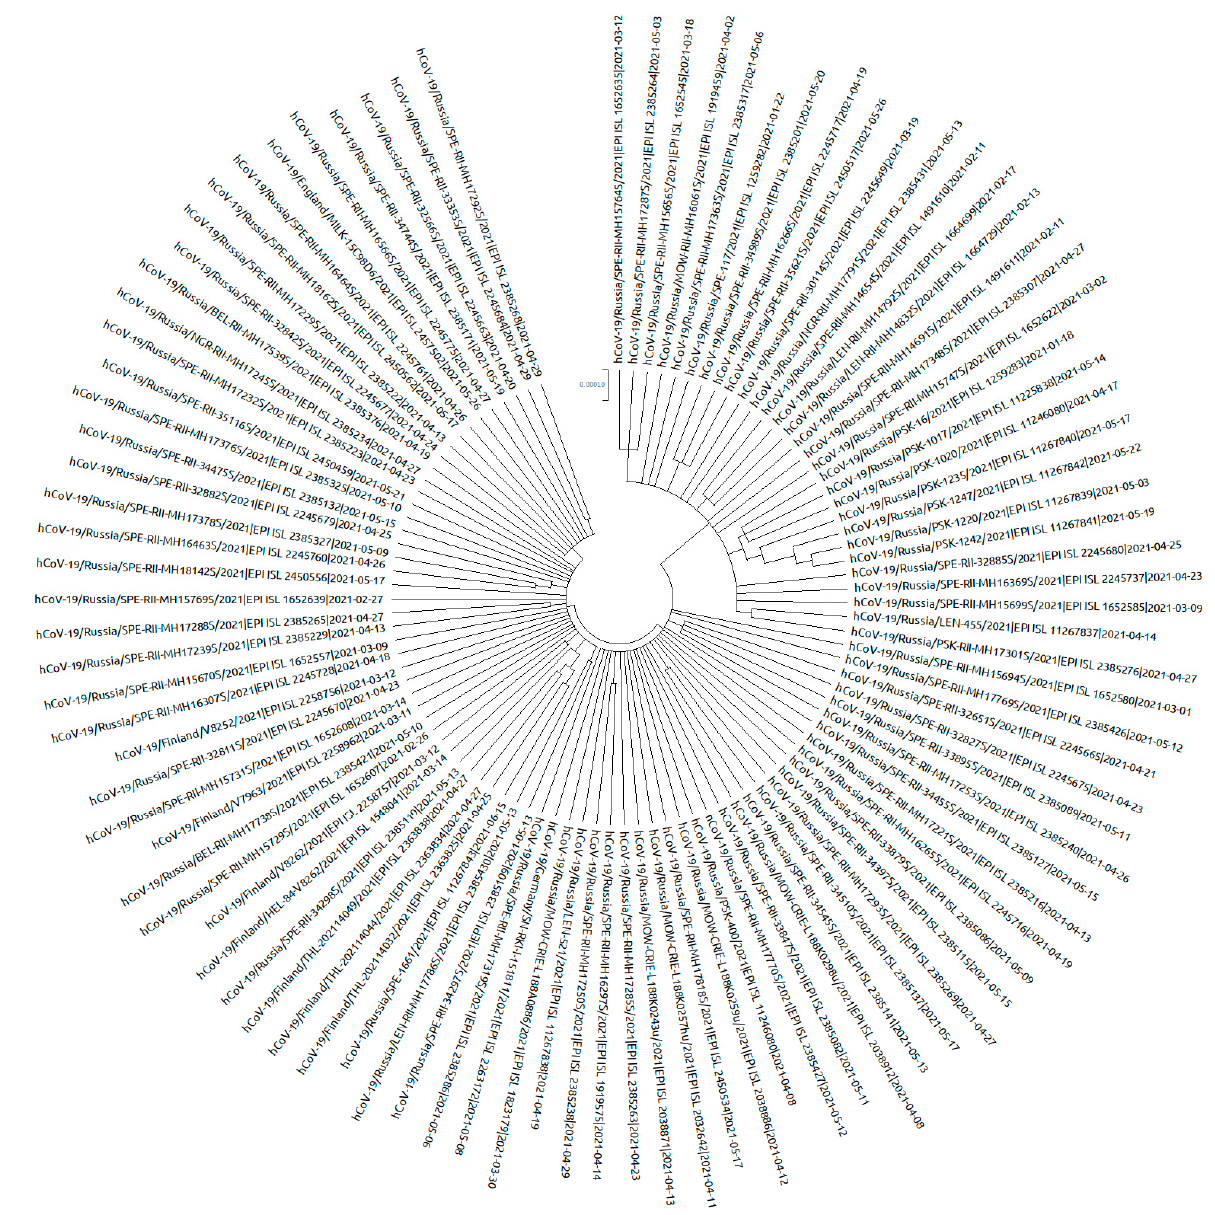
Figure 9. Phylogenetic tree of AT.1 SARS-CoV-2 variants. Sequences (98) from Russia and Europe were included in the analysis. The TN93 substitution model was chosen as optimal for 19,205 bp without gaps/missing data alignment.